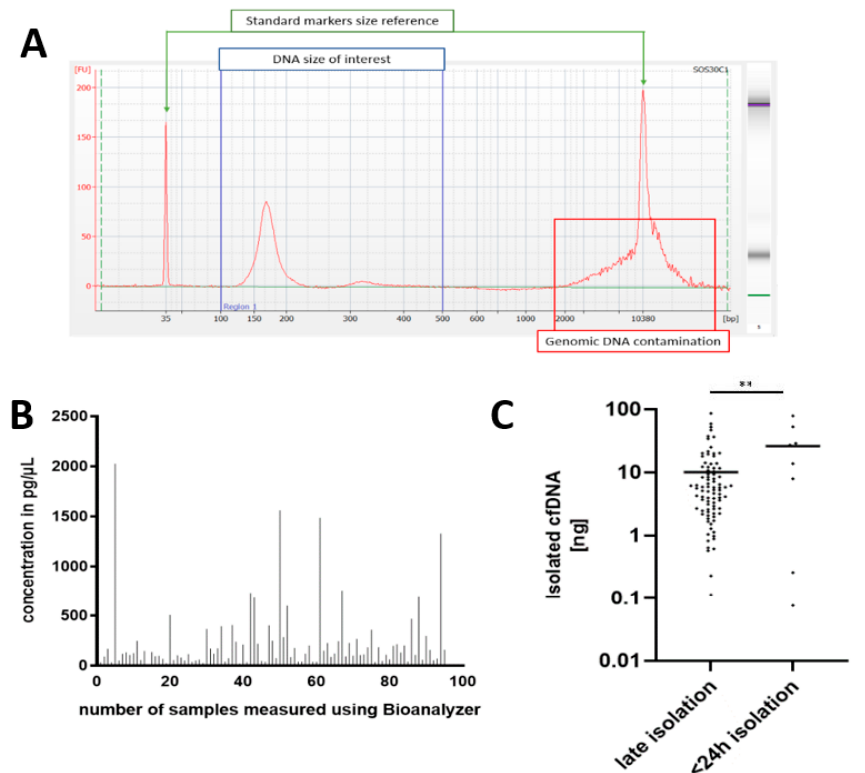
Figure 2. Quality and quantity control of ccfDNA samples evaluated using a Bioanalyzer. ( A ) Representative electropherogram: blue range highlights DNA size of interest for which concentration was determined; ( B ) concentration values for 95 ccfDNA samples measured by a Bioanalyzer; ( C ) effects of immediate versus delayed isolation on the yield of ccfDNA (blood that was left aside for more than 24 h after collection before isolation versus <24 h isolation). Statistical significance was calculated using a two-tailed t -test (** p <